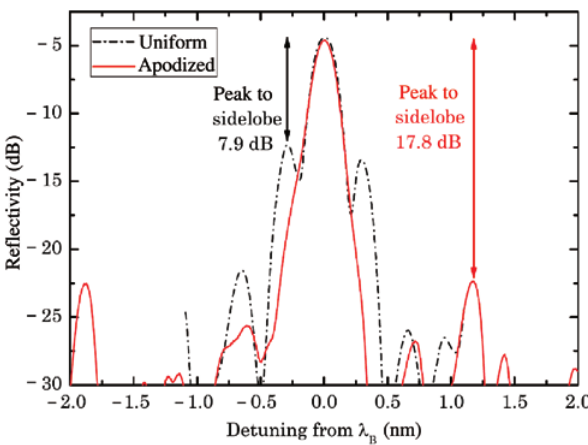
Figure 16: Comparison of a 4.4-mm-long uniform WBG and an apo- dised WBG employing a Gaussian apodisation function with 4.4 mm FWHM (10 mm total length). WBGs were both fabricated in a fused silica sample using the modu- lated burst technique. Reprinted with permission from [47].